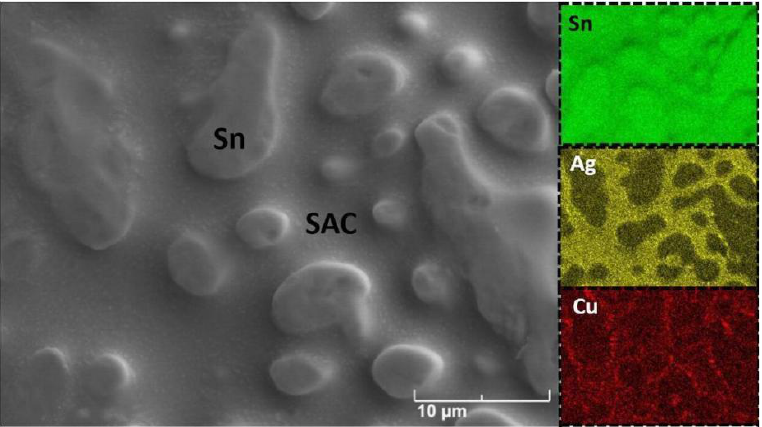
Figure 4. The SEM-EDS map scanning analysis on a local part of BGA solder ball which shows the map scanning results of Sn, Ag and Cu elements.